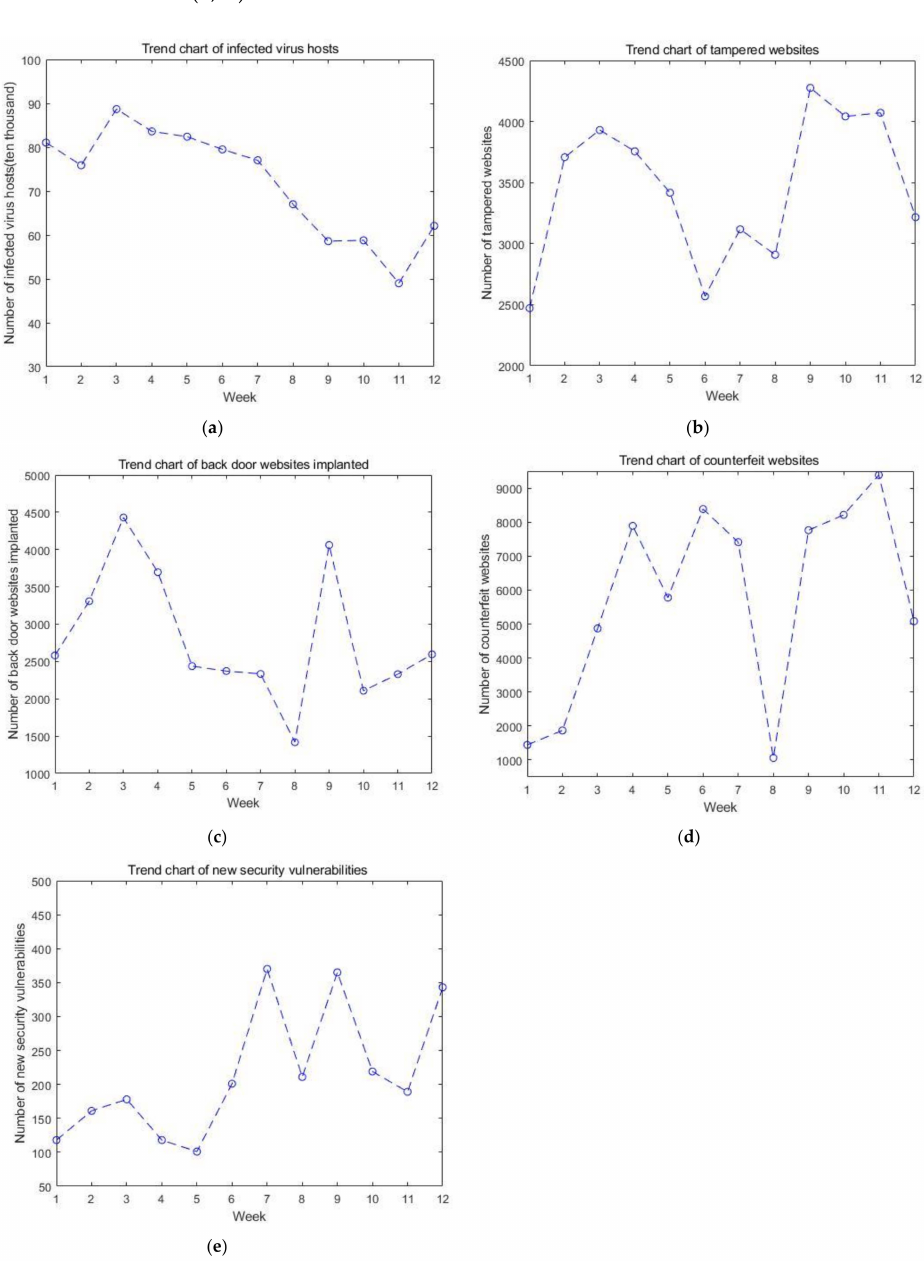
Figure 3. The trends of five types of incidents over time: ( a ) trend chart of infected virus hosts; ( b ) trend chart of tampered websites; ( c ) trend chart of backdoor websites implanted; ( d ) trend chart of counterfeit websites; and ( e ) trend chart of new security